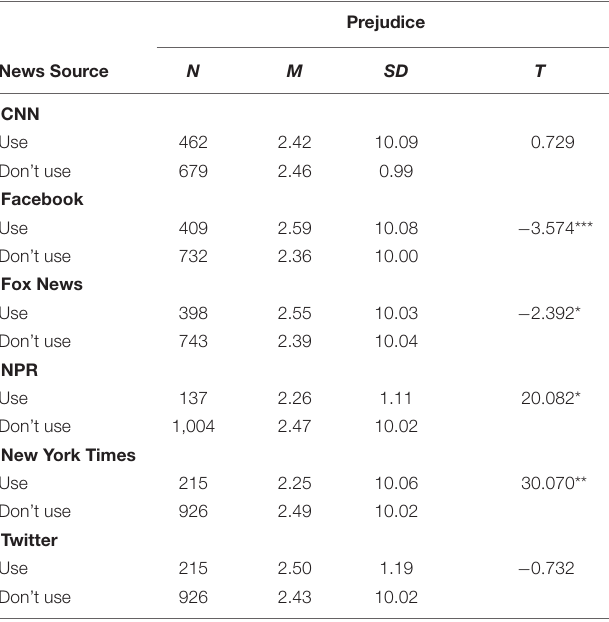
TABLE 5 | T -tests comparing prejudice scores for people who use and do not use specific news sources.